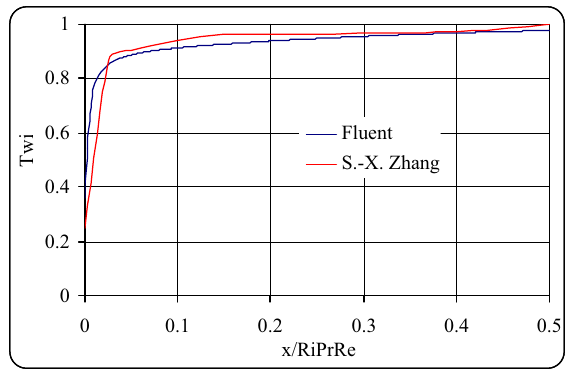
Figure 2: Dimensionless wall temperature ( T wi ) with non - dimen - sional axial coordinate for the case is: Pr = 1, Re = 50, δ /Ri = 0.08, and ksf =